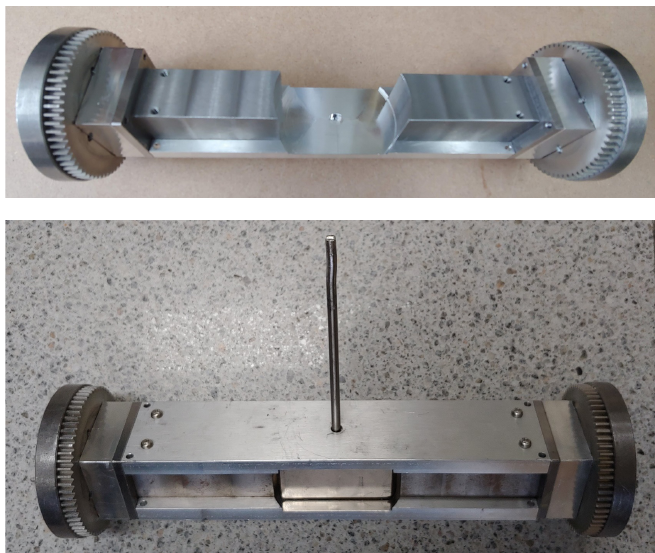
Figure 6. Pictures of a magnetic wheel pair. Top picture shows the assembled wheel pair without the permanent magnet. Bottom picture shows the permanent magnet as well as the shaft to turn the